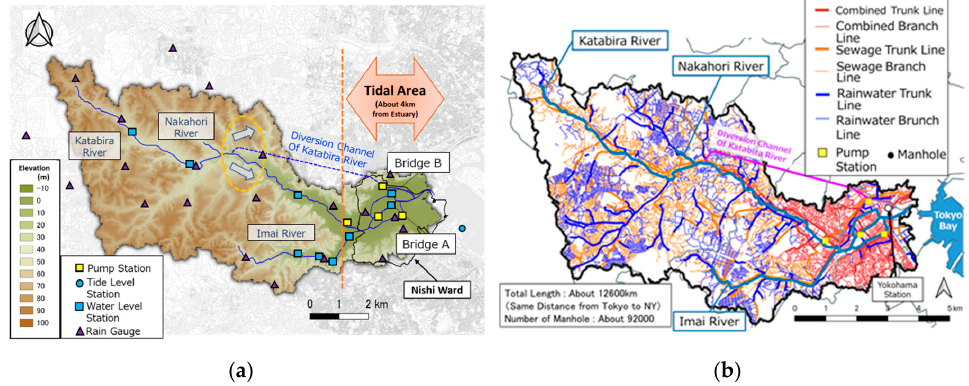
Figure 1. Overview of Katabira River basin: ( a ) elevation map; and ( b ) pipeline networks map.